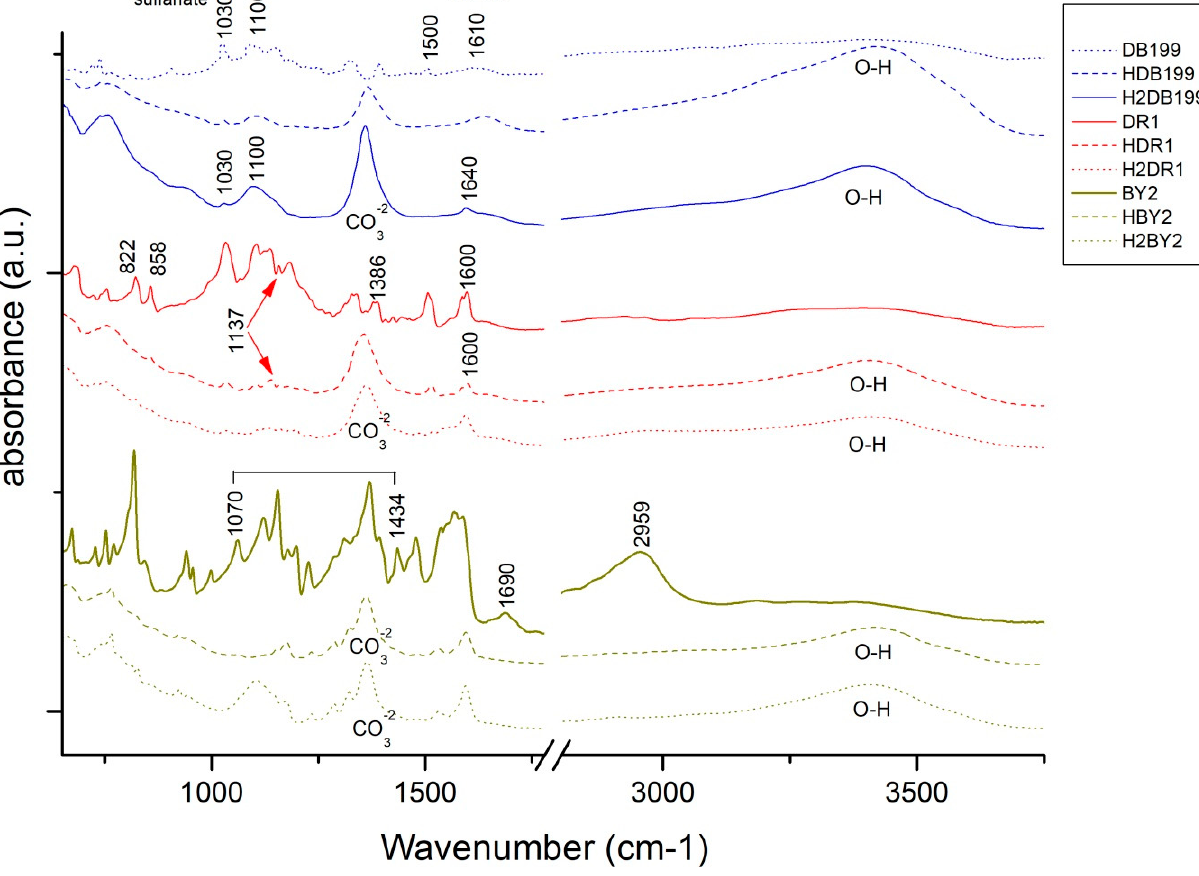
Figure 5. FTIR of DB199, BY2, DR1 and samples HDB199, HBY2, HDR1, H2DB199, H2BY2 and H2DR1.